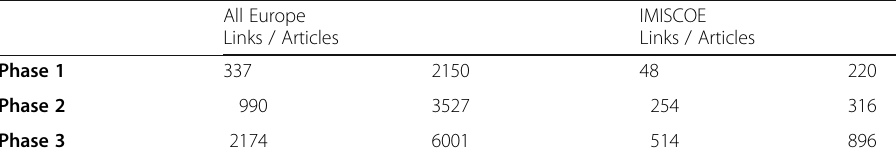
Table 1 Number of international co-authorships vs. number of articles published